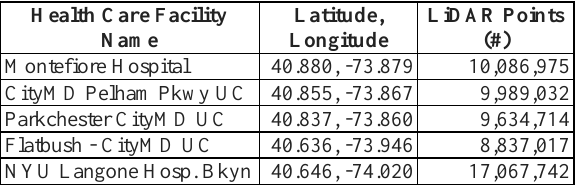
Table 2. Selected healthcare facilities and corresponding LiDAR (UC=Urgent